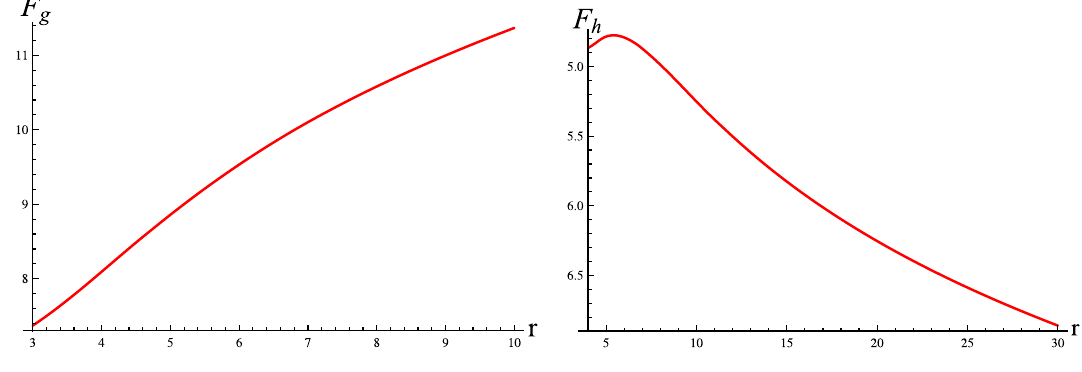
Fig. 14 Plots of F g and F h versus r for f ( G ) = χ 7 G 2 + χ 8 G + χ 1 with w = −